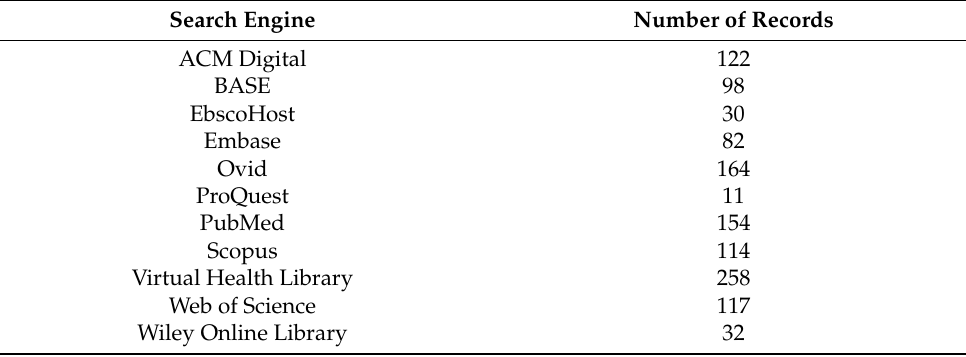
Table A2. The numbers of records identified by each search